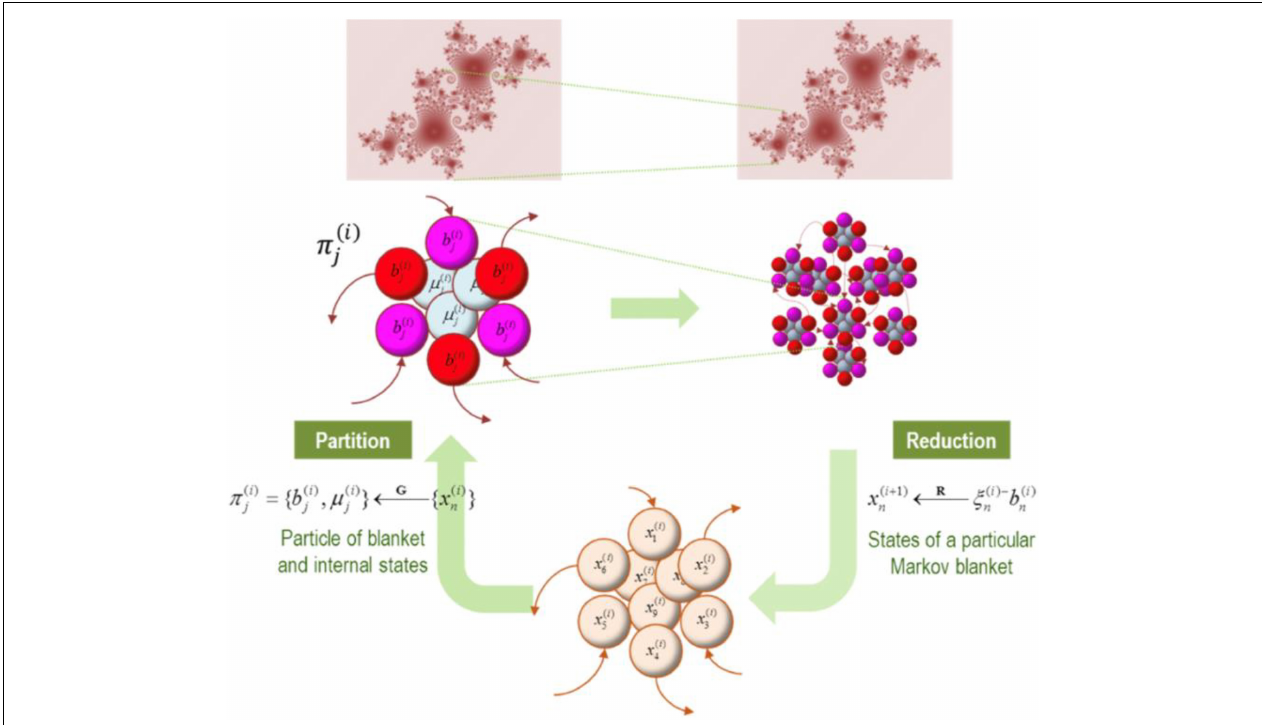
FIGURE 8 | In this figure we have an illustration of progressively larger scales (and slower dynamics) arising from subordinate levels. In the upper panels, the conditional dependencies among these vector states (i.e., eigenstates) define a particular partition into particles. This partition then equips each particle with a bipartition into blanket and internal states, where blanket states comprise active (red) and sensory (magenta) states. The behavior of each particle can now be summarized in terms of (slow) eigenstates or mixtures of its blanket states to produce states at the next level or scale. Vector states (i.e., eigenstates) on the bottom can be partitioned into particles (upper panels). Each particle can then be partitioned into internal and blanket states, which involve active (red) and sensory states (magenta). The behavior of each particle can be summarized either as (slow) eigenstates or mixtures of its blanket states to produce states to the next level or scale (i.e., an ensemble of vector states). Note that the first uses the particular partition to group subsets of states (G); while the second uses eigenstates of the resulting blanket states to reduce dimensionality (R) (Figure reproduced from Friston,